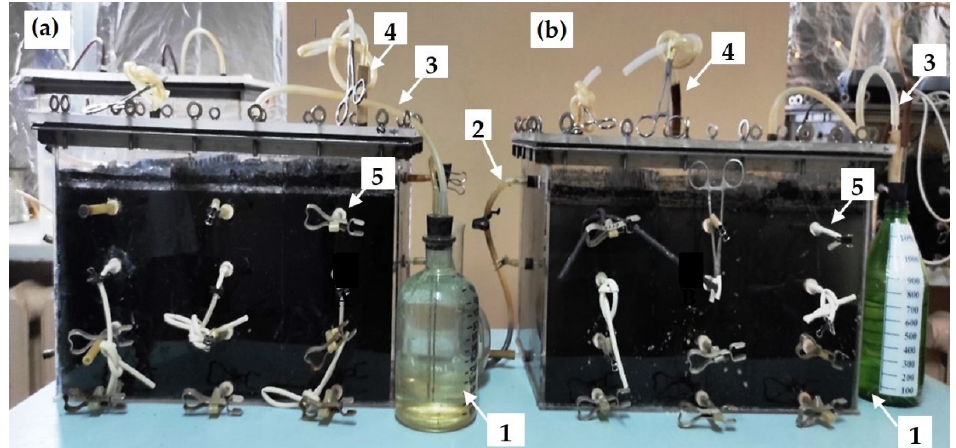
Figure 2. Methane tank for the methanogenic fermentation of organic acids and alcohols. The phot shows two connected 50-L modules 1 and 2 for the fermentation of high concentrations (1000–2000 mg/L) of organic compounds ( a ),( b ). The system included gas holders (1), a tube connecting the two modules (2), gas collecting tubes (3), gas sampling tubes (4), and leachate sampling ports (5).